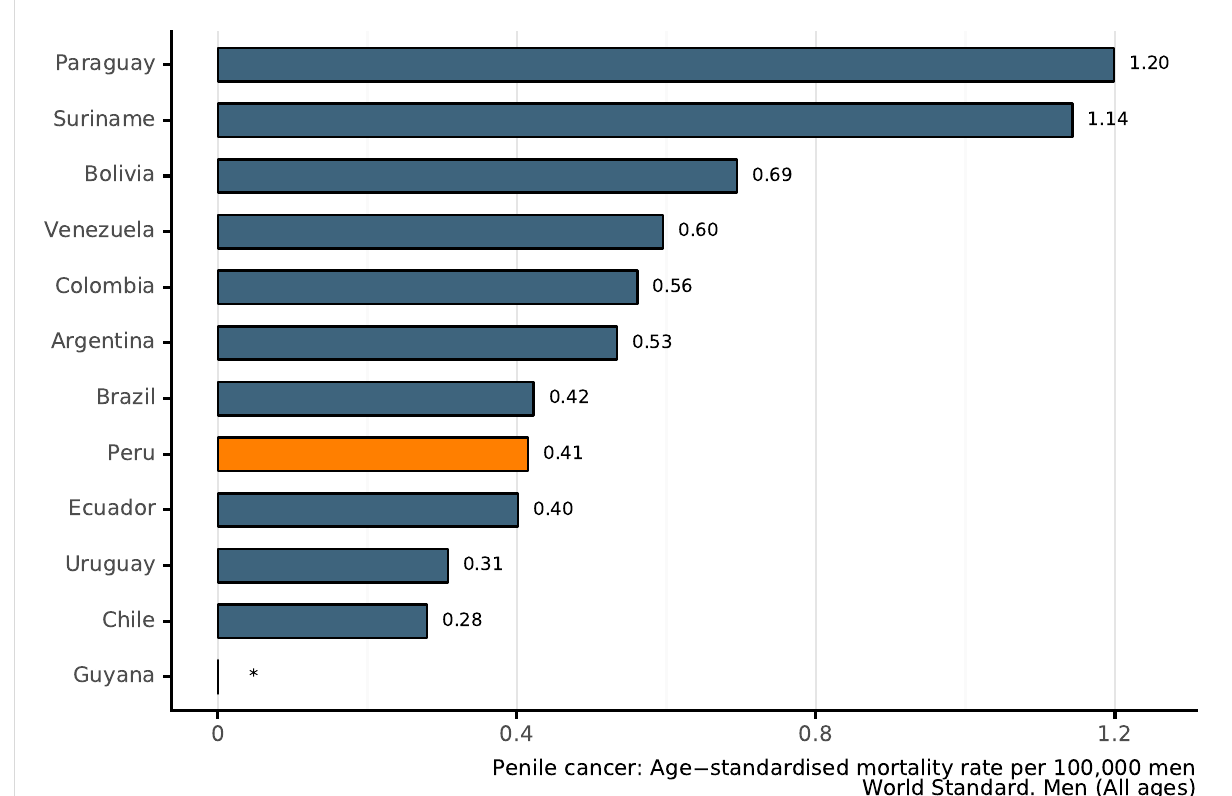
Penile cancer: Age standardised mortality rate per 100,000 men World Standard. Men (All